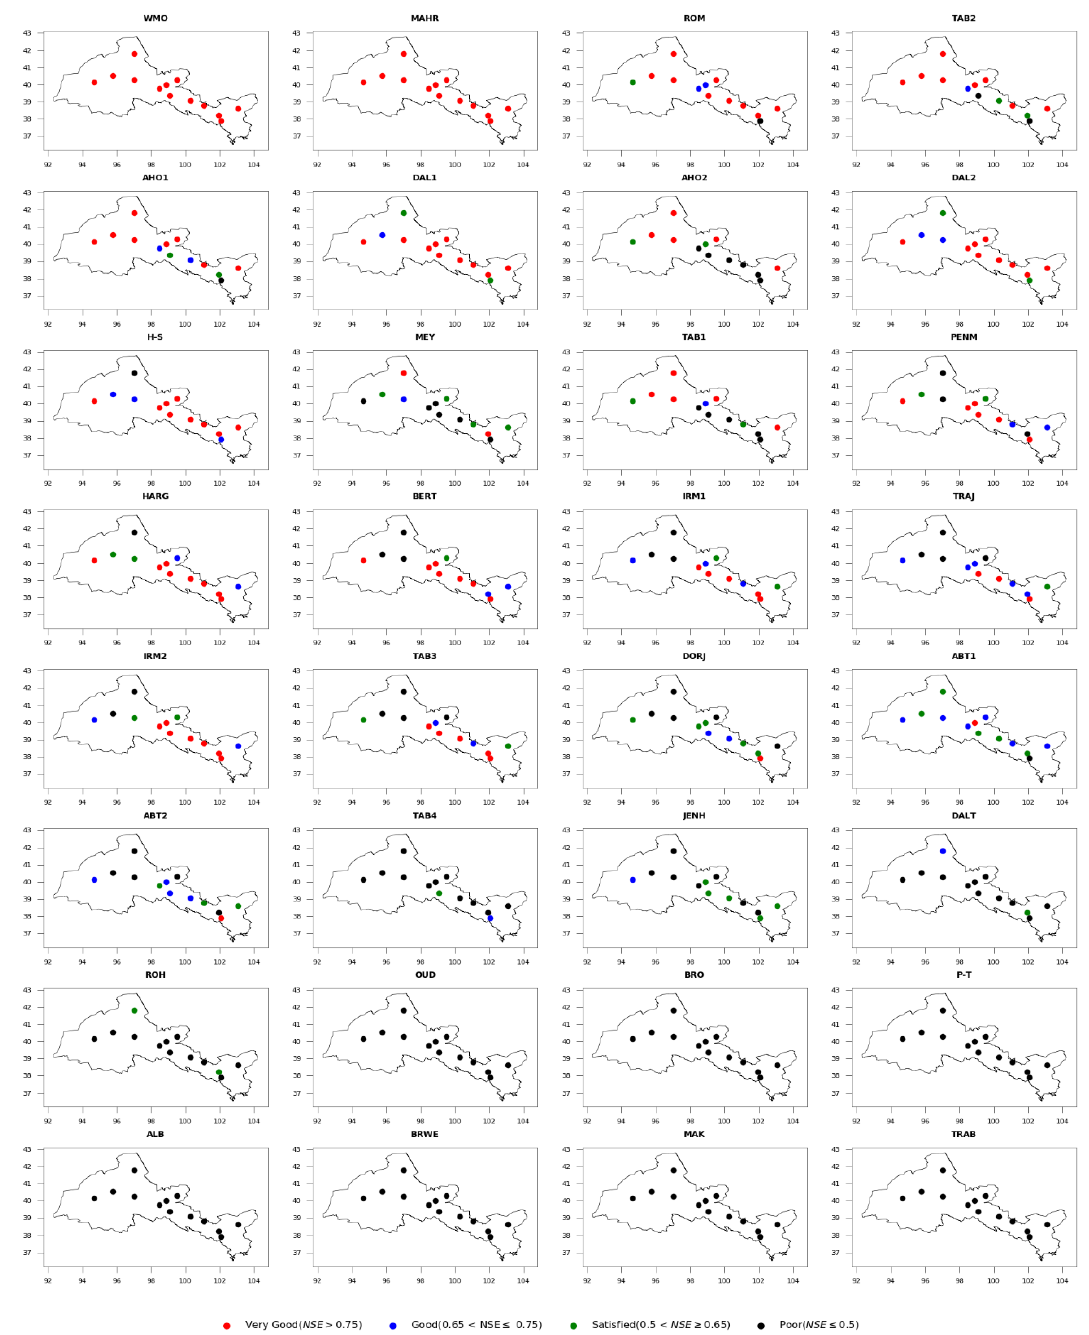
Figure 5. Spatial distribution of monthly Nash–Sutcliffe efficient ( NSE ) values computed from the 32 simple ET 0 models in reference of the PM-FAO56 method over the Hexi corridor region (Full names of each model are shown in Table 2).